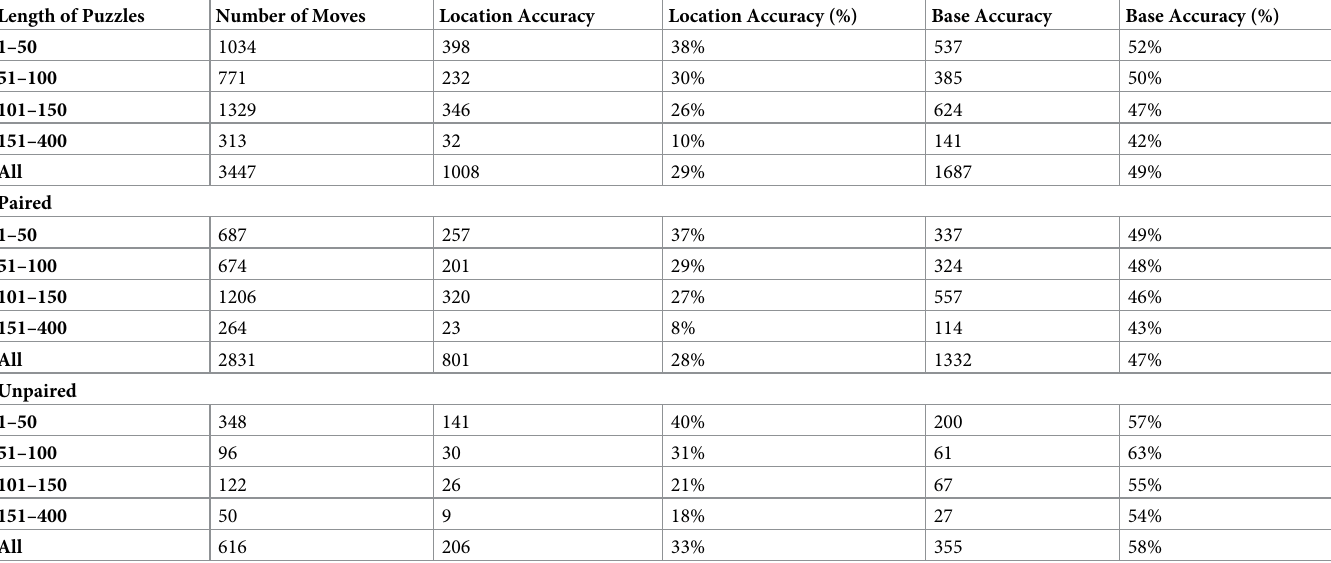
Table 3. EternaBrain CNN accuracies on eternamoves-select , grouped by length of puzzle and paired/unpaired status of nucleotide at which move was applied. Length of Puzzles Number of